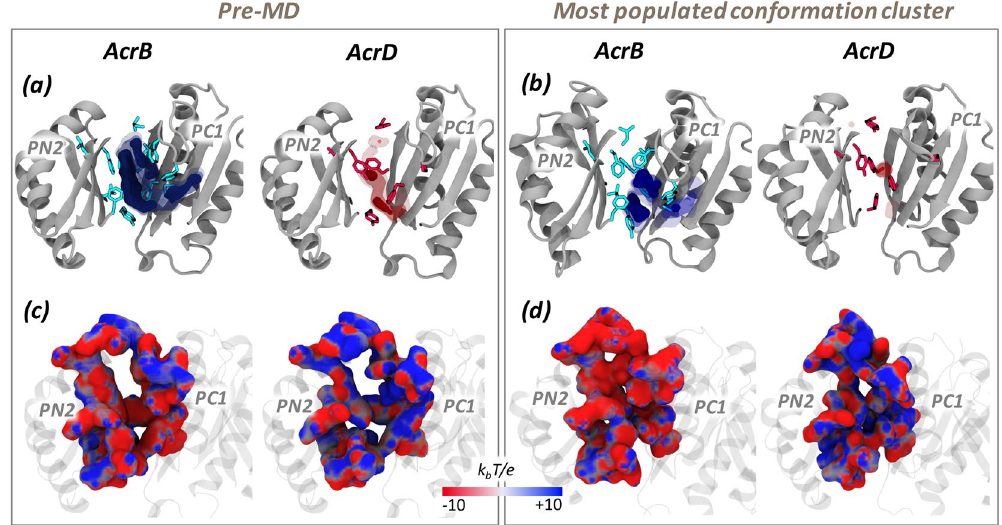
Figure 7. MLP and electrostatic potential of DP in the Tight protomer of AcrB and AcrD. See Fig. 4 for further details.